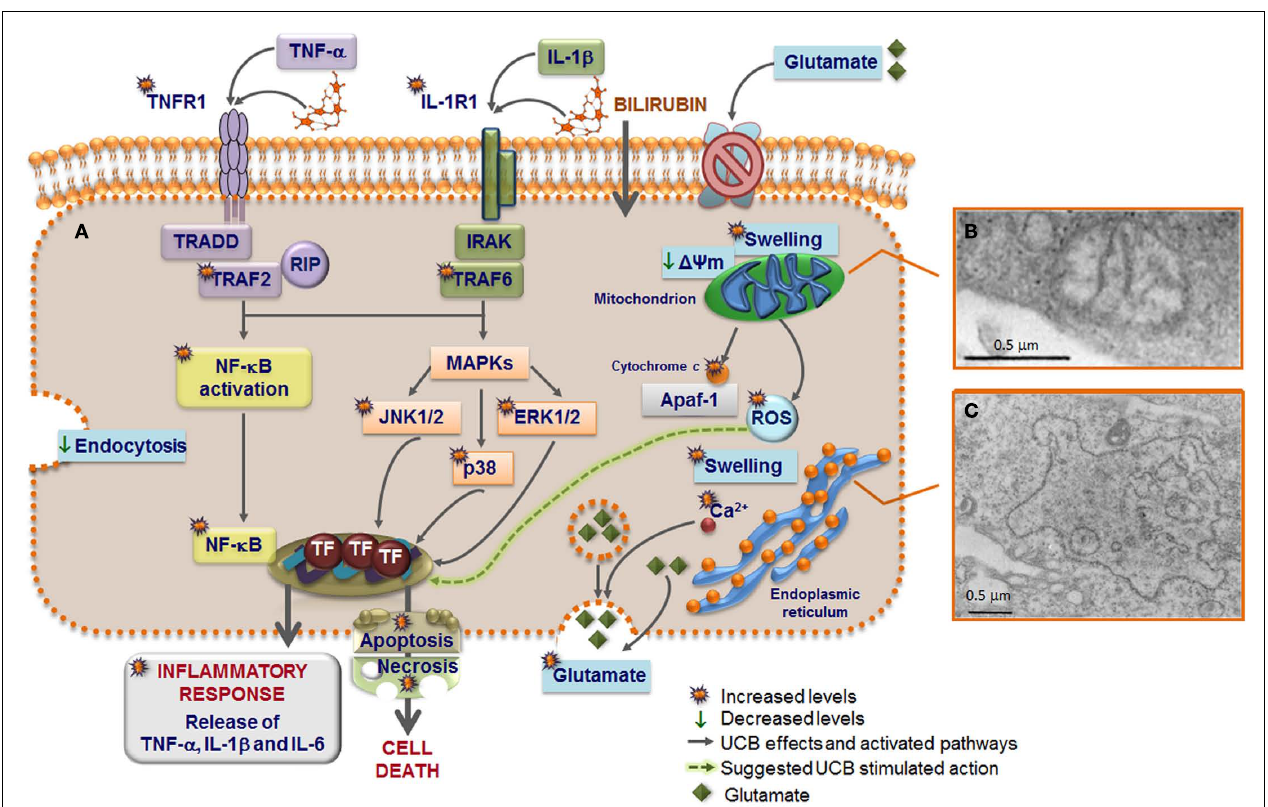
FIGURE 5 | Model of astrocytic reactivity to unconjugated bilirubin (UCB) evidencing the pathways involved in the release of pro-inflammatory cytokines and in cell demise (A) mediated by mitochondrial (B) and rough endoplasmic reticulum (ER) (C) abnormalities. UCB causes inhibition of glutamate uptake and elevation of intracellular calcium (Ca 2 + ) levels that modulate the exocytosis of glutamate, thus increasing the extracellular content of glutamate. High concentrations of UCB disrupt endocytosis in astrocytes and produce mitochondria swelling, mediated by the opening of the permeability transition megapore, and ER enlargement probably preceded by ER stress response and release of Ca 2 + . UCB-induced apoptosis include mitochondrial permeabilization and cytochrome c efflux. UCB induces the secretion of both tumor necrosis factor (TNF)- α and interleukin (IL)-1 β , which stimulate the synthesis of IL-6 after the first 4h of interaction.The primary inflammatory stimulus causes a rapid and